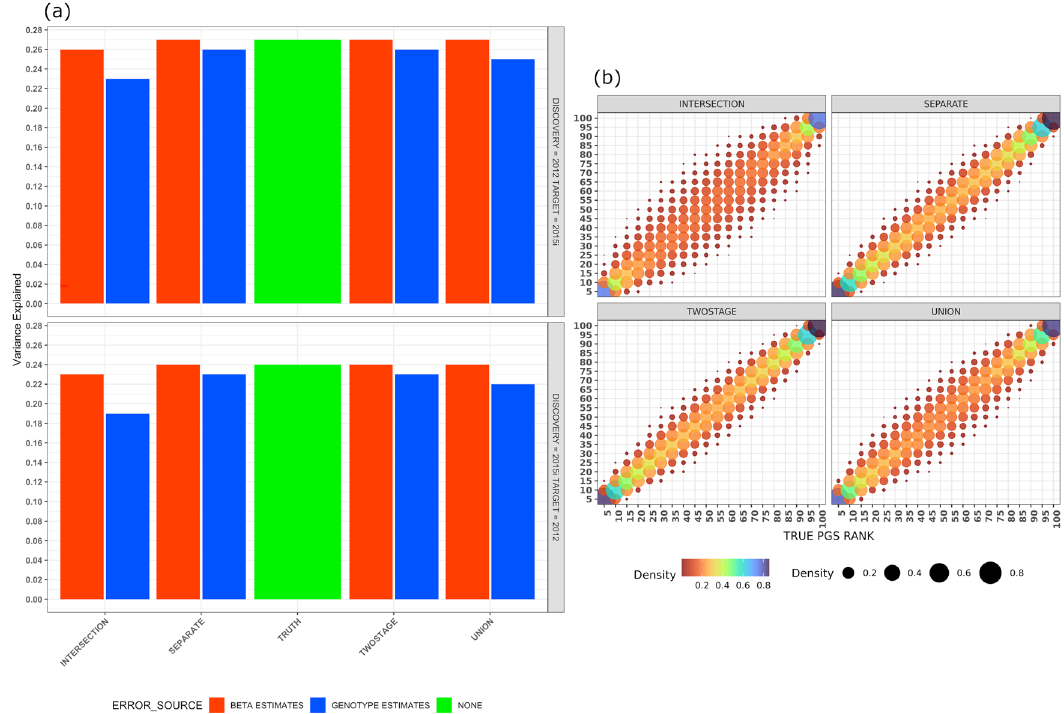
Fig. 4 The performance of polygenic scores is attenuated when using imputed data, which affects both population-level measures such as variance explained in a simulated phenotype, and in individual-level metrics, such as rank concordance when compared to true genotypes. a Shows the attenuation in variance explained by a PGS when an error introduced by using imputed dosages resides in either the discovery stage or in scoring. The green bars are the reference, where true genotypes were used for both discovery and scoring. Red bars indicate that imputed dosages were used in discovery, while blue bars indicate that imputed dosages were used for scoring. b Shows the rank concordance between individuals in iPSYCH2015i ranked according to their PGS calculated using true genotypes on X axis and imputed dosages from each data integration protocol, across the four fi gure panels on the Y axis. The rank concordance with the truth set is higher (Red: Low, Blue: High in heatmap gradient) when employing the separate or two-stage protocols as compared to union or intersection